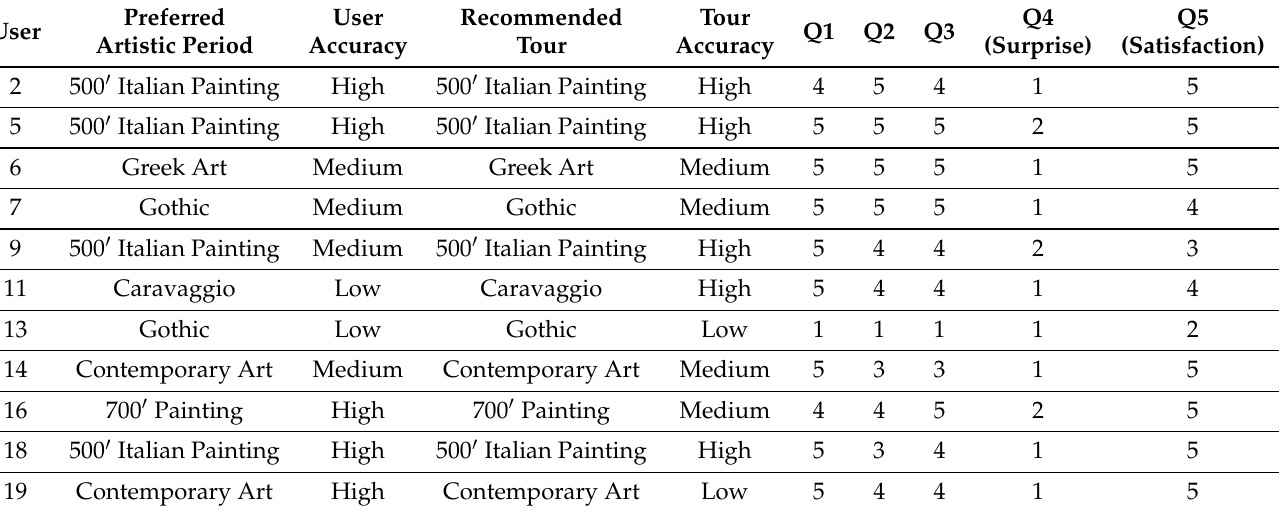
Table 2. This table reports the answers to the questions in the survey proposed by the robot after it provides literal help to the user. In these cases, the robot recommends a tour corresponding to the artistic period the user indicated as preferred in the history of